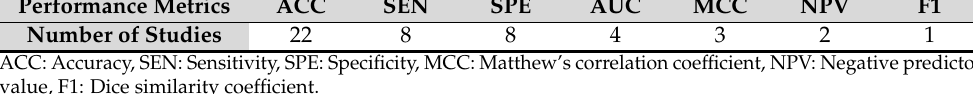
Figure 5. The performance metrics vs. the number of studies (ACC: Accuracy, SEN: Sensitivity, SPE: